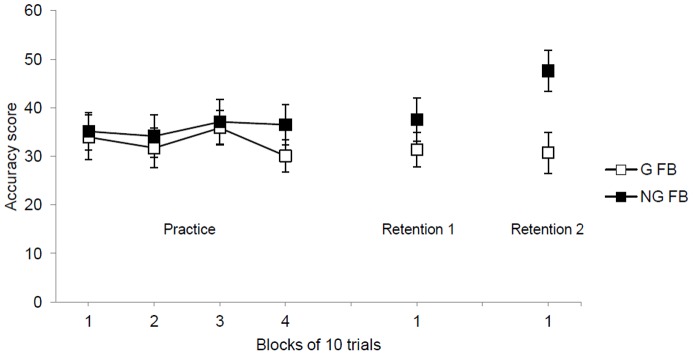
Accuracy scores during practice and retention tests for the G-FB and NG-FB groups.Error bars indicate standard errors.